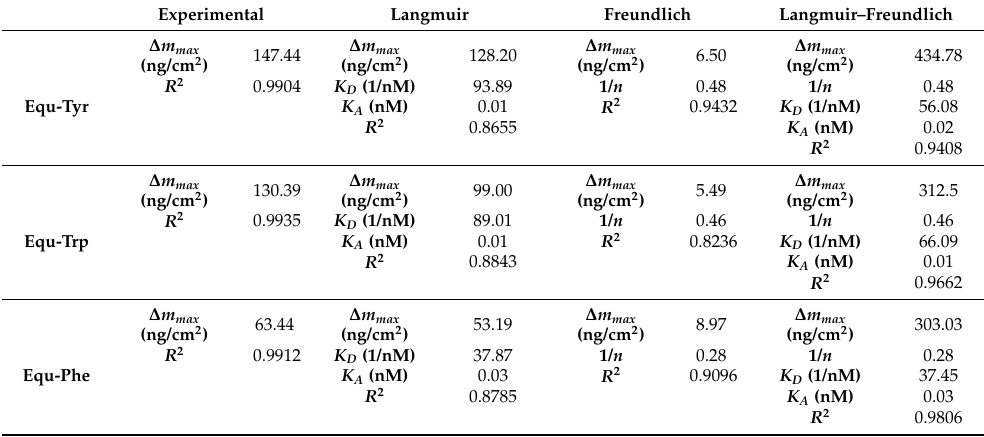
Table 3. Binding isotherms of Equ with different amino acids. Experimental